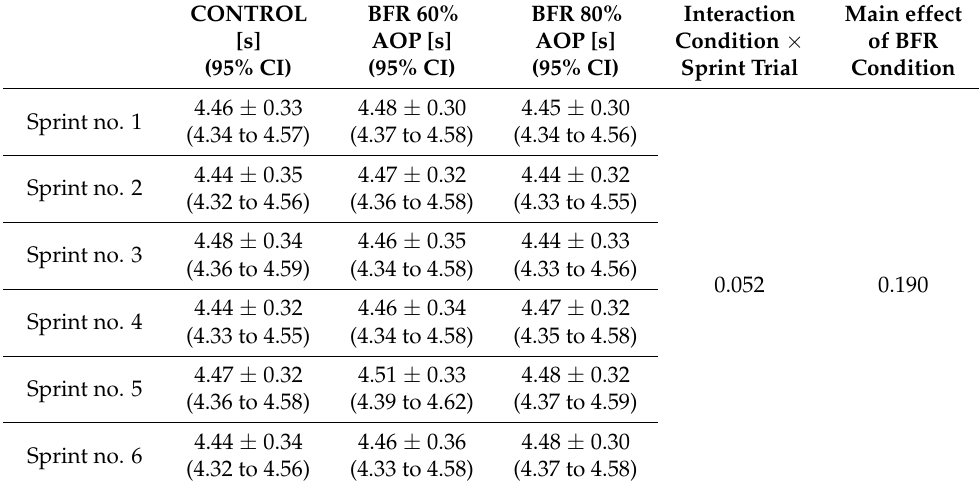
Table 1. Difference in performance variables during control and BFR conditions.